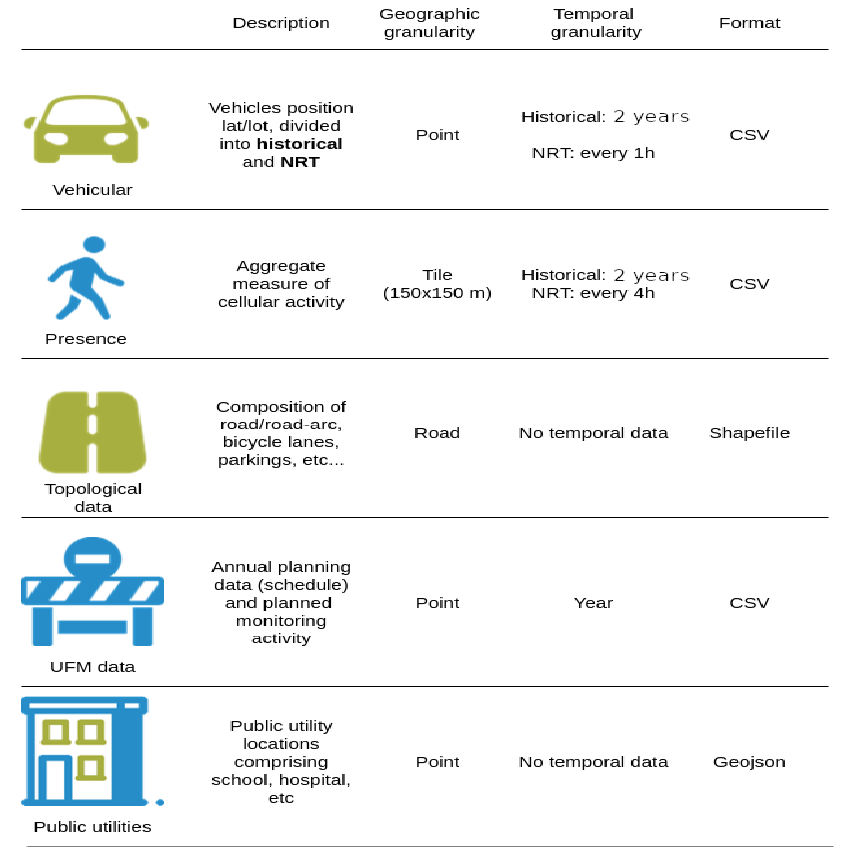
Figure 1. IPPODAMO data